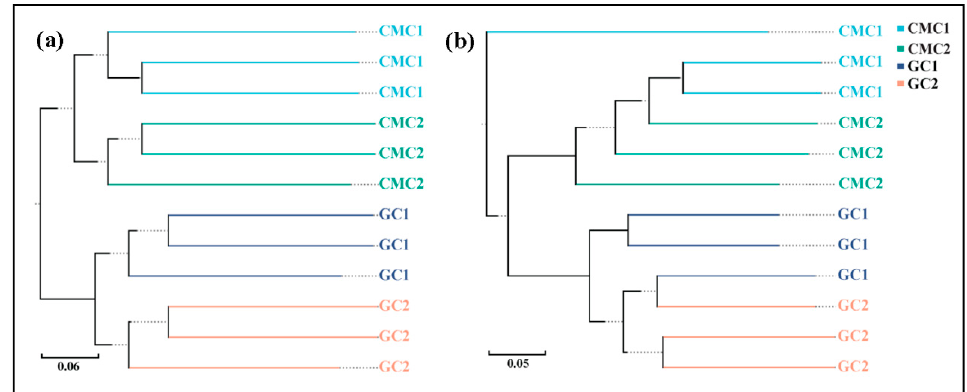
Figure 4. UPGMA clustering of sediment bacterial communities in aquaculture ponds based on ( a ) Jaccard and ( b ) Bray–Curtis distances at the OTU levels. See Figure 1 for abbreviations. The same labels represent sediment samples of the ponds from each site.